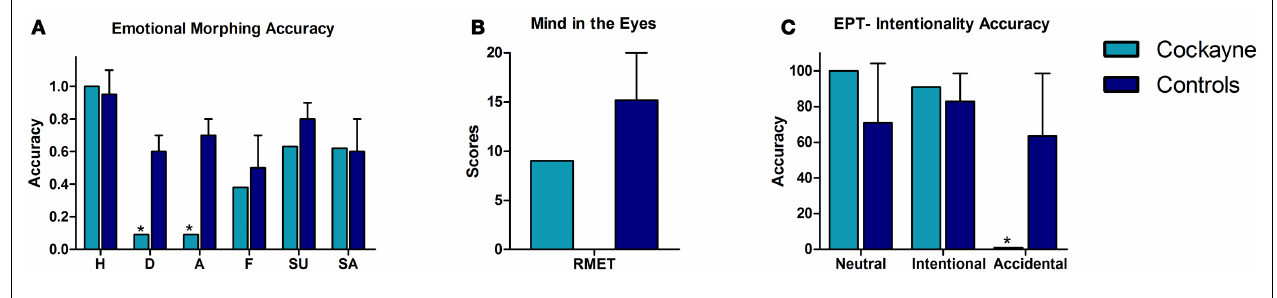
FIGURE 2 | Performance of the CS patient and controls in social cognition tasks . (A) Emotional morphing (accuracy per category). H, happiness; D, disgust; A, anger; F, fear; SU, surprise; SA, sadness.